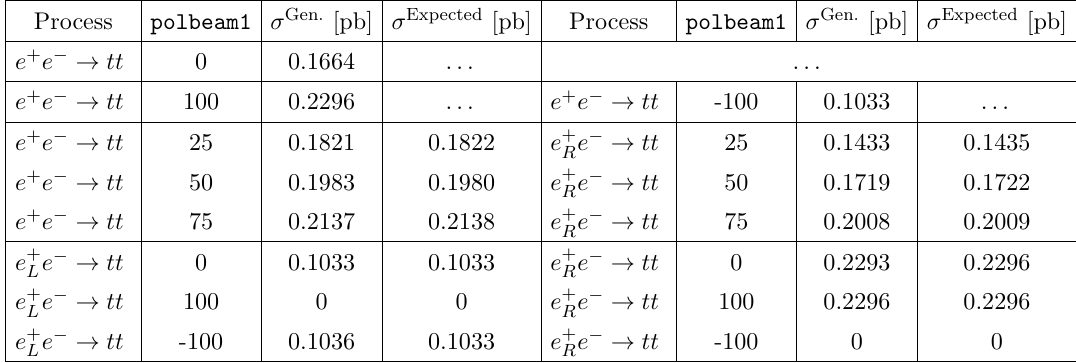
Table 8. Cross sections [pb] for the process e + e (cid:0) ! tt at particles, totally and partially polarized beams in the partonic c.m. frame using the polbeam1 steering commands ( polbeam2=0 ), totally polarized IS particles in the partonic c.m. frame